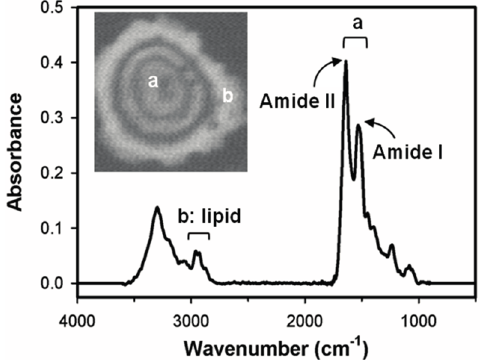
Figure 2. The chemical information of biomolecular distribution within a cell including amide I (~1540 cm − 1 ) and amide II (~1640 cm − 1 ) of proteins detected in nucleus and lipid (2800–3000 cm − 1 ) shown by fourier transform infrared (FT-IR) spectrum and microscopy image (inserted